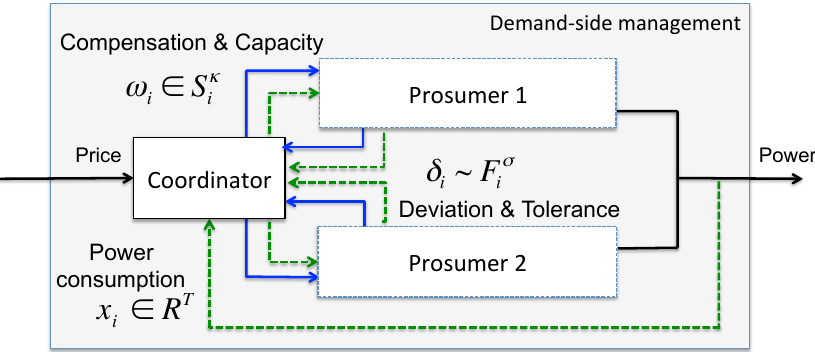
Figure 9. Prosumer community coordination scheme (example for two prosumers). The prosumers coordinate off-line and real-time control variables via a coordinator. The dotted green lines indicate off-line management: power consumption x i , capacity S κ real-time management: compensation w i and deviation δ i